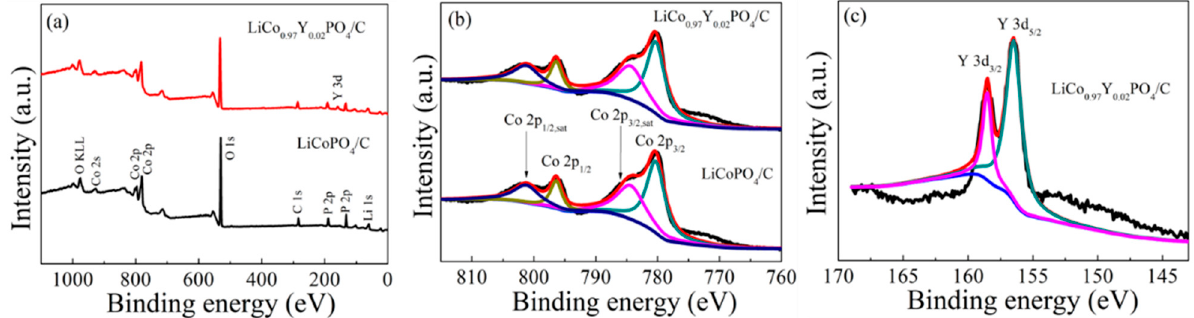
Figure 6. XPS spectrum of LiCoPO 4 /C and LiCo 0.97 Y 0.02 PO 4 /C cathode material.